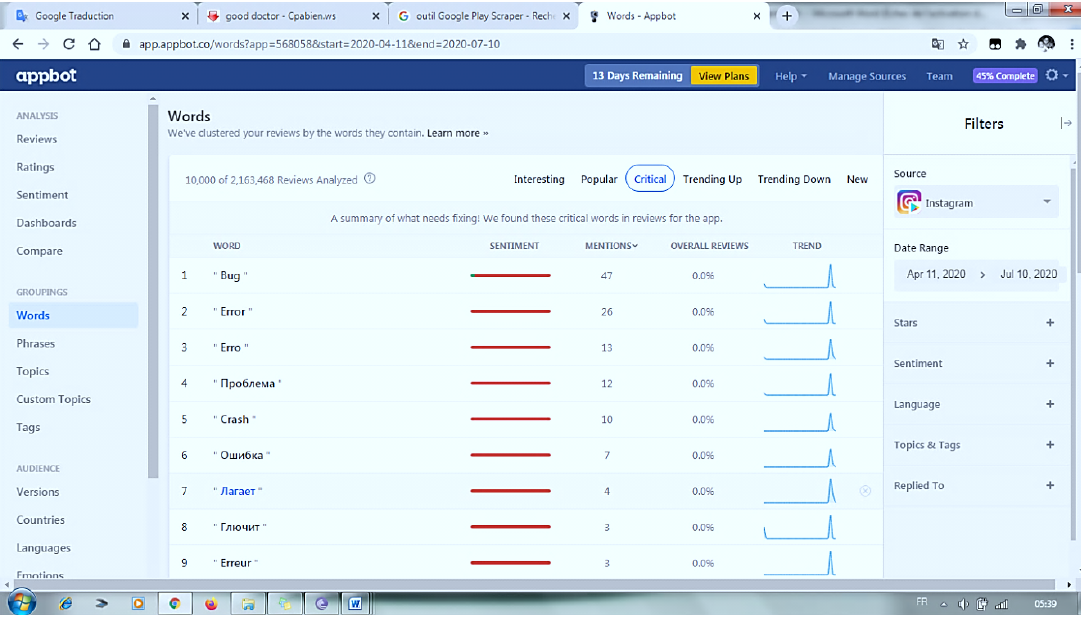
Figure 2. Excerpt of critical words of the Instagram